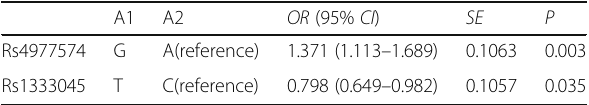
Table 4 Fisher ’ s exact test of alleles